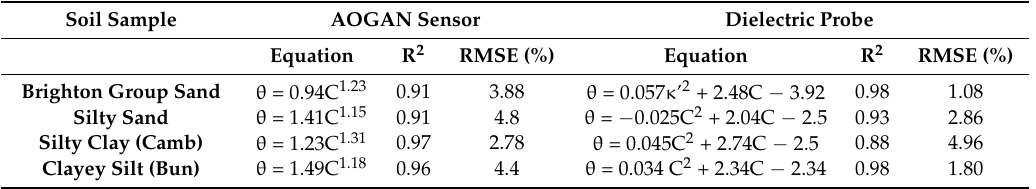
Table 8. Summary of the AOGAN sensor and dielectric probe performance against each soil sample.